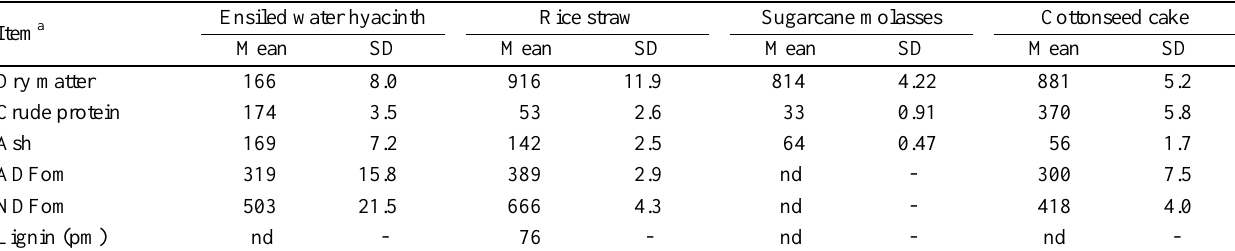
Table 1. Dry matter and chemical composition (g/kg DM) of the wilted water hyacinth, rice straw, sugarcane molasses and cottonseed cake Ensiled water Item a